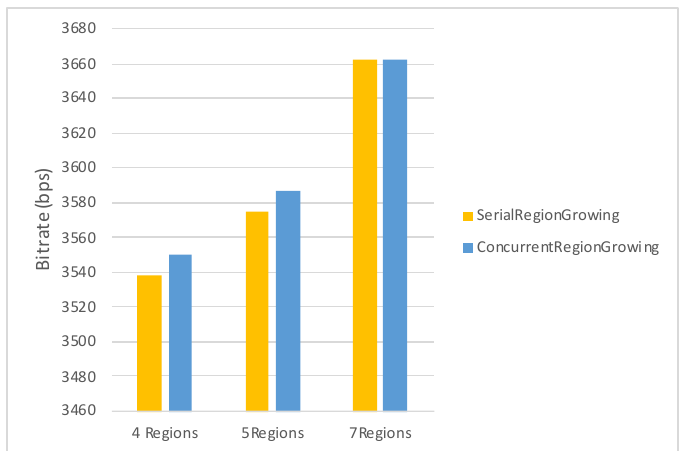
Figure 17. Average bitrate performance for 4, 5 and 7 regions (UVG dataset).